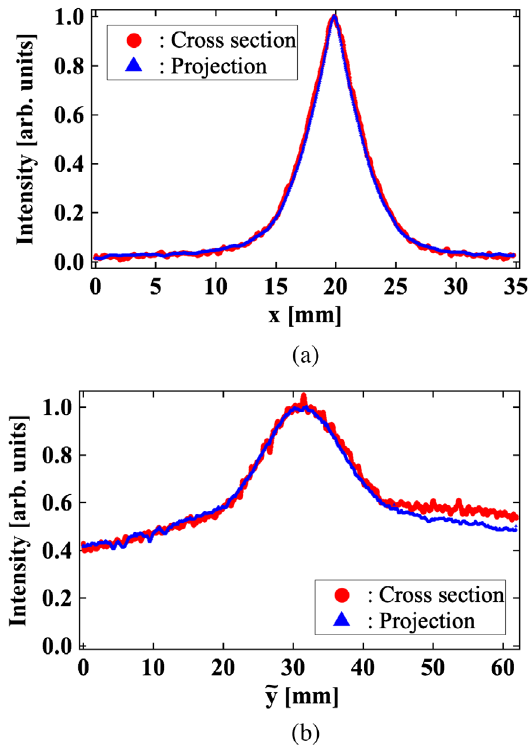
FIG. 13. The measured distributions g ð ˜ x; ˜ y Þ at the inlet pressure of 100 Pa and 50 μ s × 12 ; 000 pulse integration. (a) Vertical distributions of the luminous intensity corresponding to the beam profiles along the x axis. (b) Horizontal distributions of the luminous intensity corresponding to the beam profiles along the y